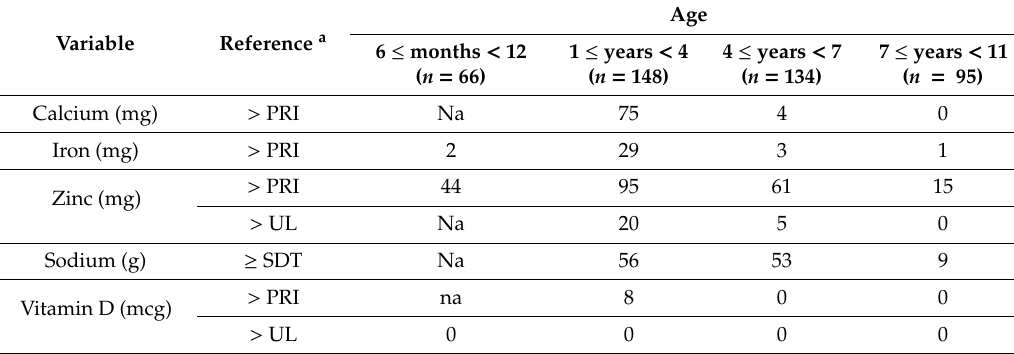
Table 12. Number of infants / children who exhibited a daily intake of minerals and / or vitamin D above the reference PRI, STD, and / or UL value, by age †